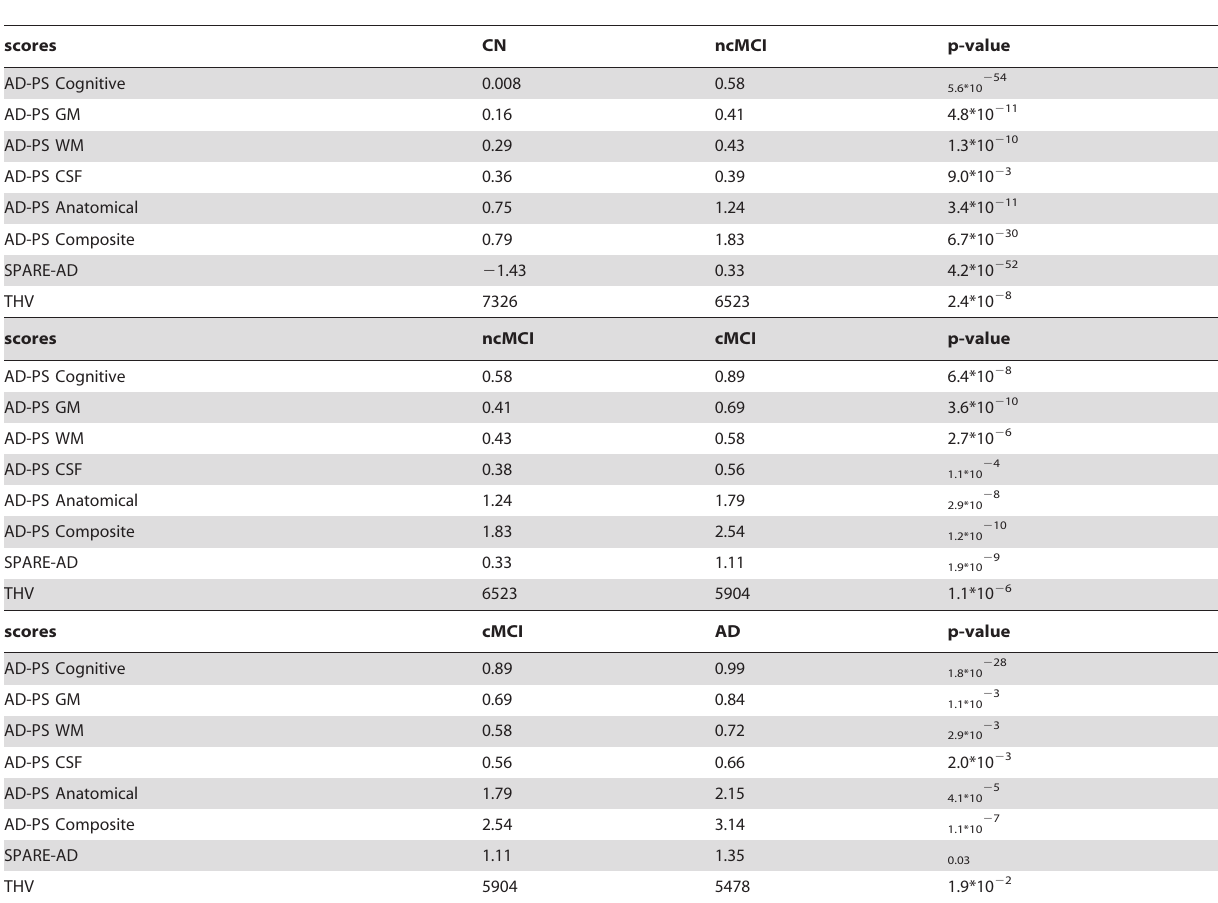
Table 4. Median AD-PS scores by type of information, SPARE-AD index and total hippocampal volume at baseline are presented.